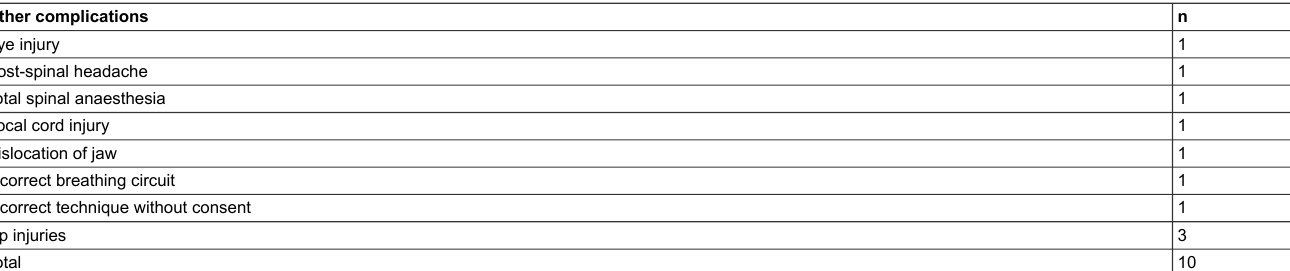
Table 3: Complications that only occurred one to three times and summarised as "others".